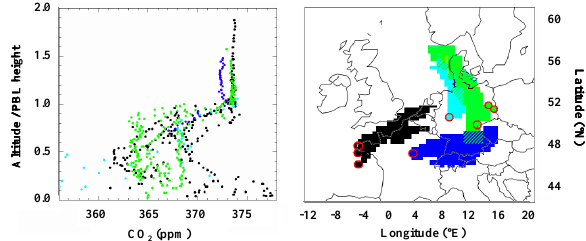
Fig. 12. CAATER 1 vertical variability analysis. Left panel: all CO 2 profiles binned over 50m layers and standardized to their re- spective PBL height. Right panel: schema of the regions covered by the back-trajectories of the profiles (profile locations are indicated by circles). Colors of right and left panels